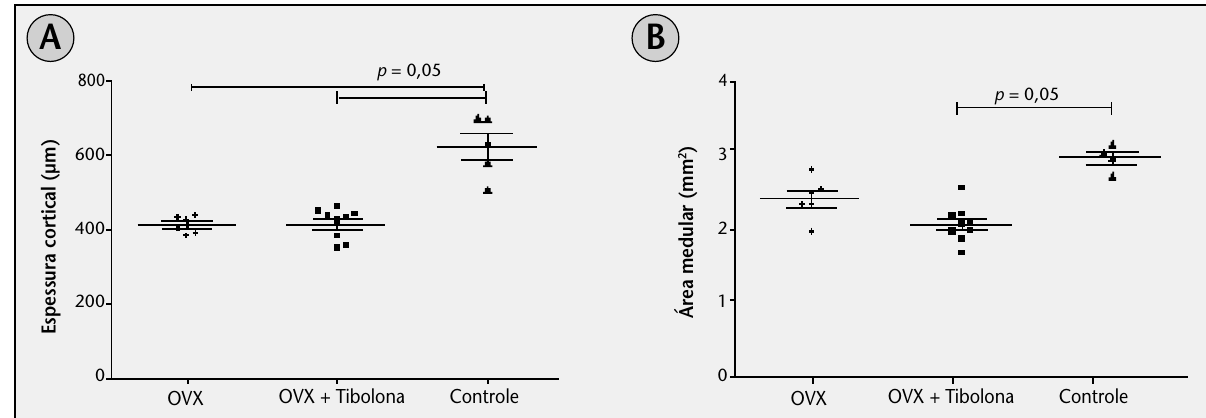
Figura 5 – Histomorfometria da diáfise femoral. (a) Espessura cortical; (b) área medular. Teste Kruskal-Wallis e Dunn’s